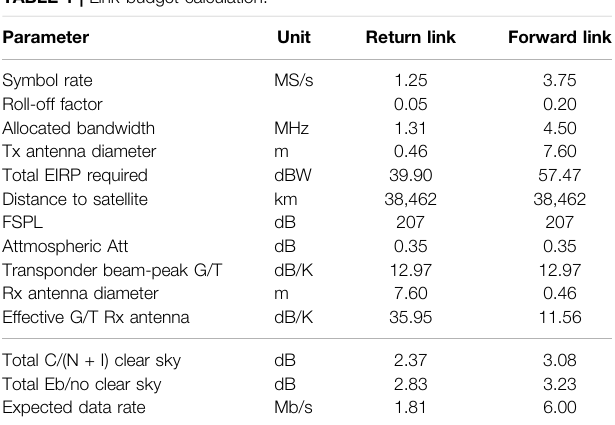
TABLE 1 | Link-budget